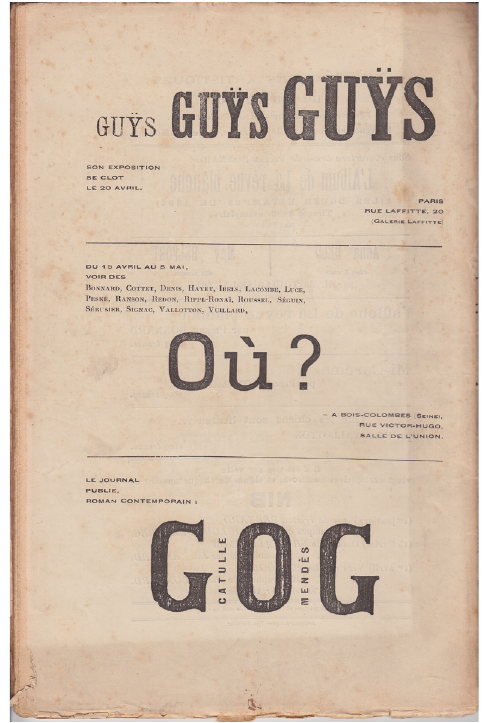
Fig. 6 La Revue blanche , 8.45 (15 April 1895), between p. 384 and the end of the issue.